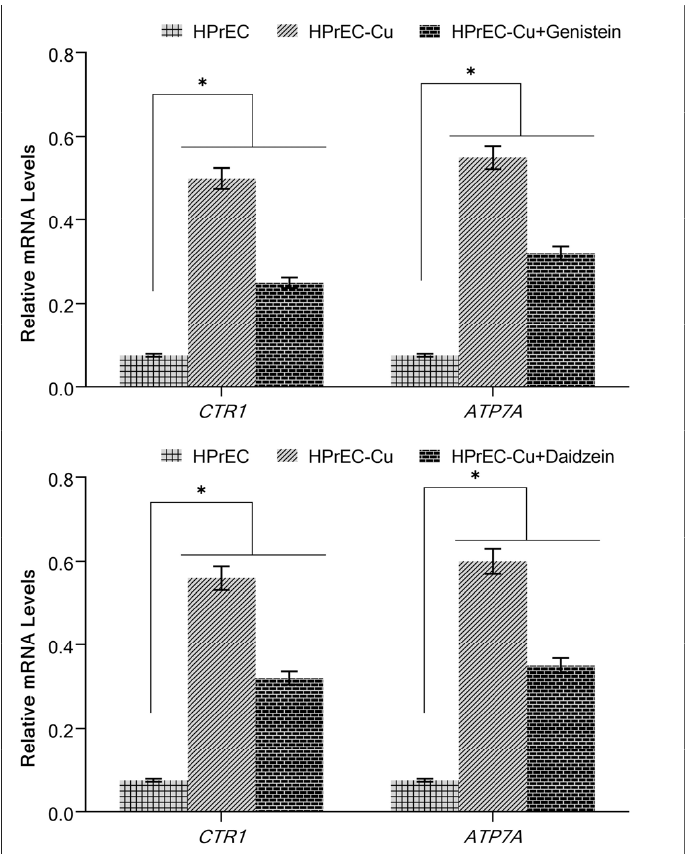
Figure 8. The effect of isoflavones on the increased mRNA levels of copper transporters CTR1 and ATP7A in HPrEC-Cu cells relative to parental HPrEC cells. As mentioned in Section 4, CTR1 and ATP7A mRNA expression was measured using real-time PCR. Only HPrEC-Cu cells (regular HPrEC cells cultured in a medium containing 25 µM CuCl 2 ) with elevated mRNA expression of copper transporters were treated with genistein/and daidzein (50 µM). Values reported are mean ± S.E. of three independent experiments. * p value < 0.01 when compared to control.